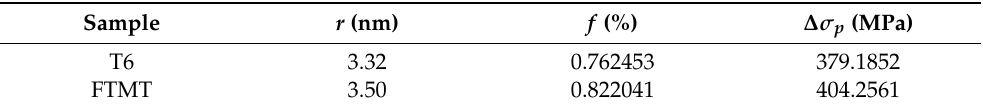
Table 4. The mean diameter and volume fraction of precipitates for Al-Mg-Zn-Cu alloy samples under different processes.